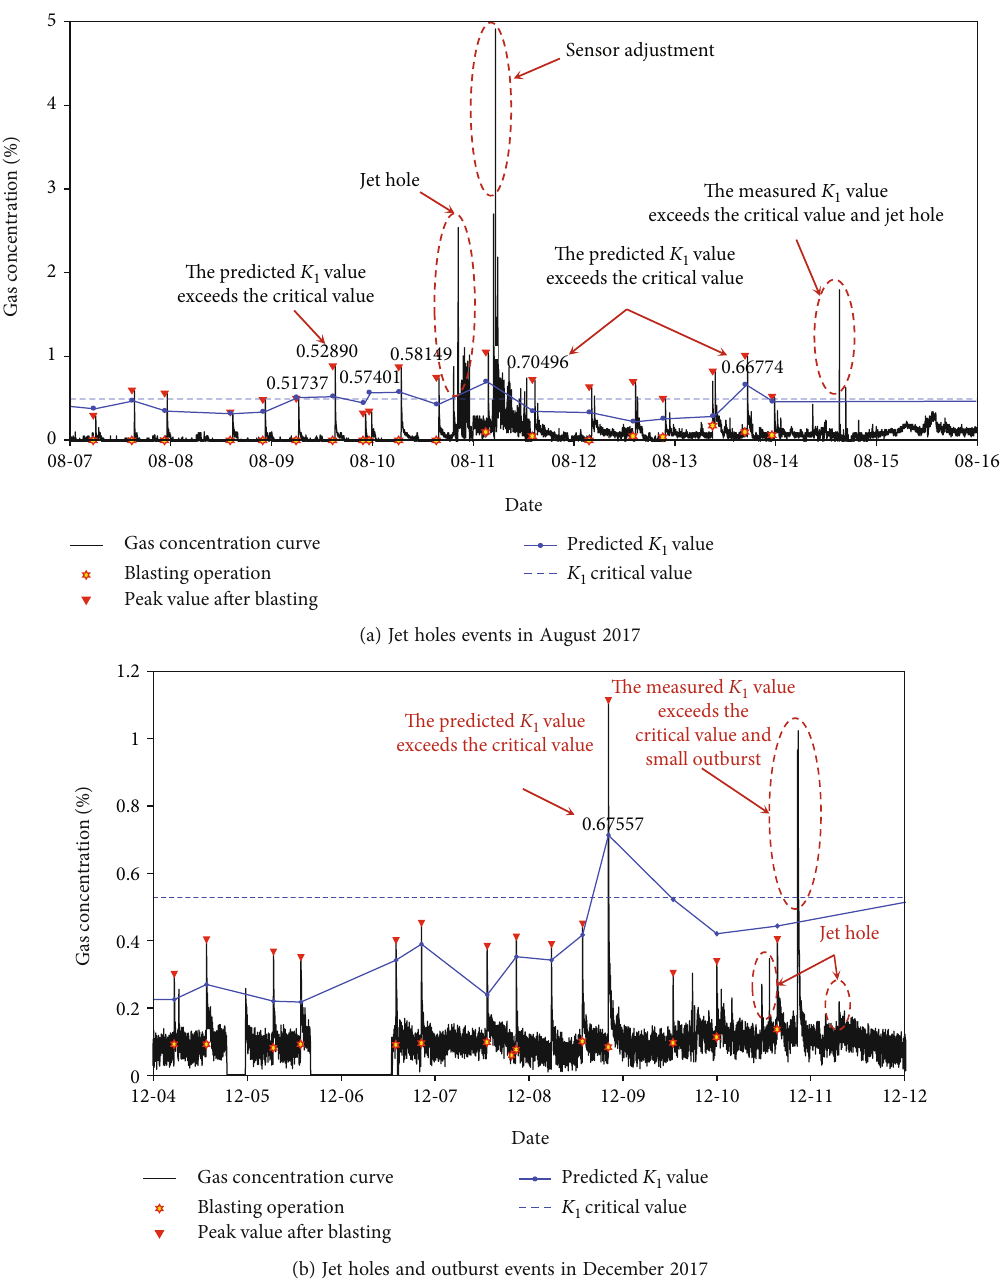
Figure 13: Analysis of outburst risk prediction